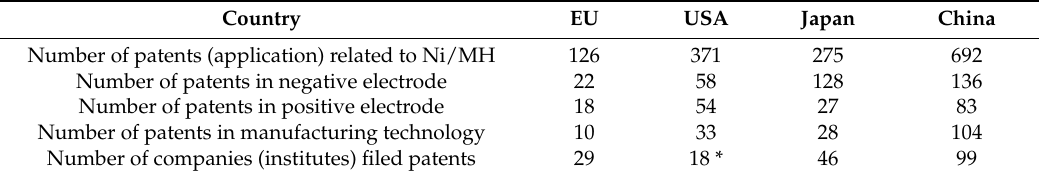
Table 2. Comparison of numbers of patents (applications) filed in EU, USA, Japan, and China and number of associated companies (institutes). * The number of companies used in USA only counts for American companies (institutes). Country EU Number of patents (application) related to Ni/MH 126 Number of patents in negative